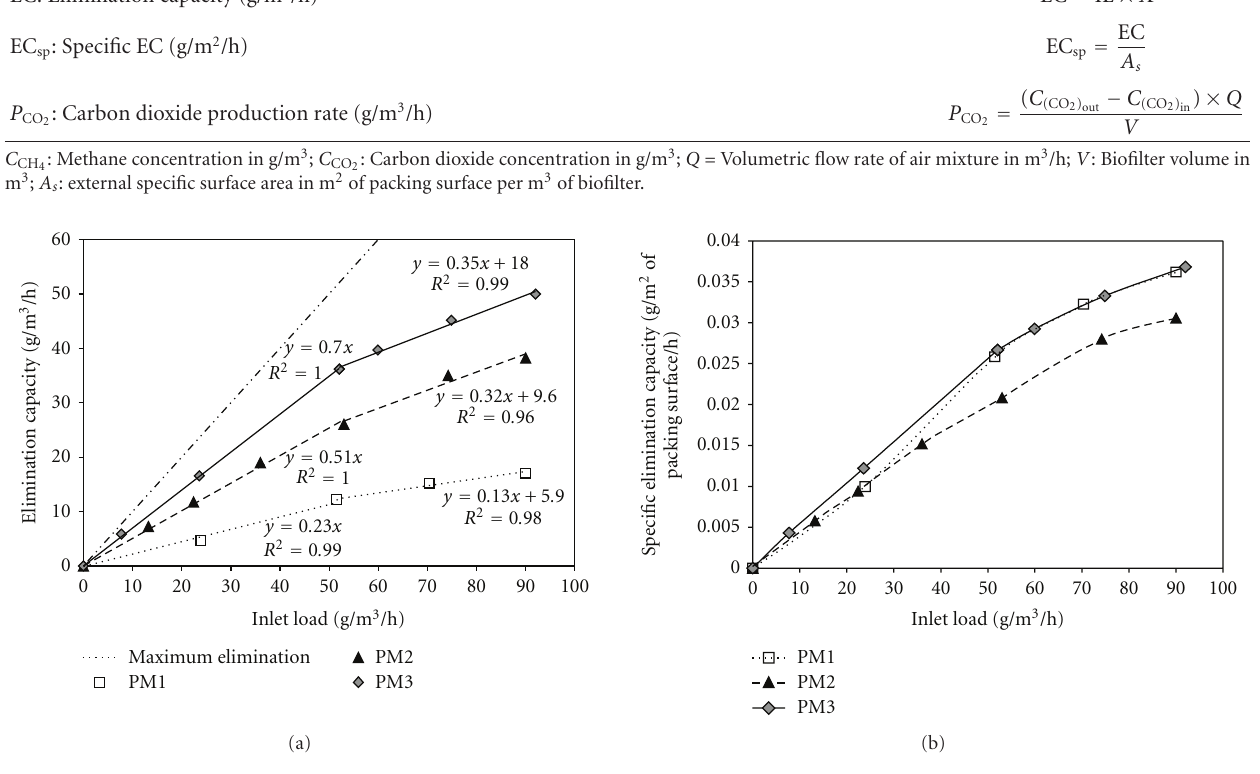
Figure 2: (a) EC of CH 4 as a function of the CH 4 IL for the 3 tested packing materials. (b) EC sp of CH 4 as a function of the CH 4 IL for the 3 tested packing